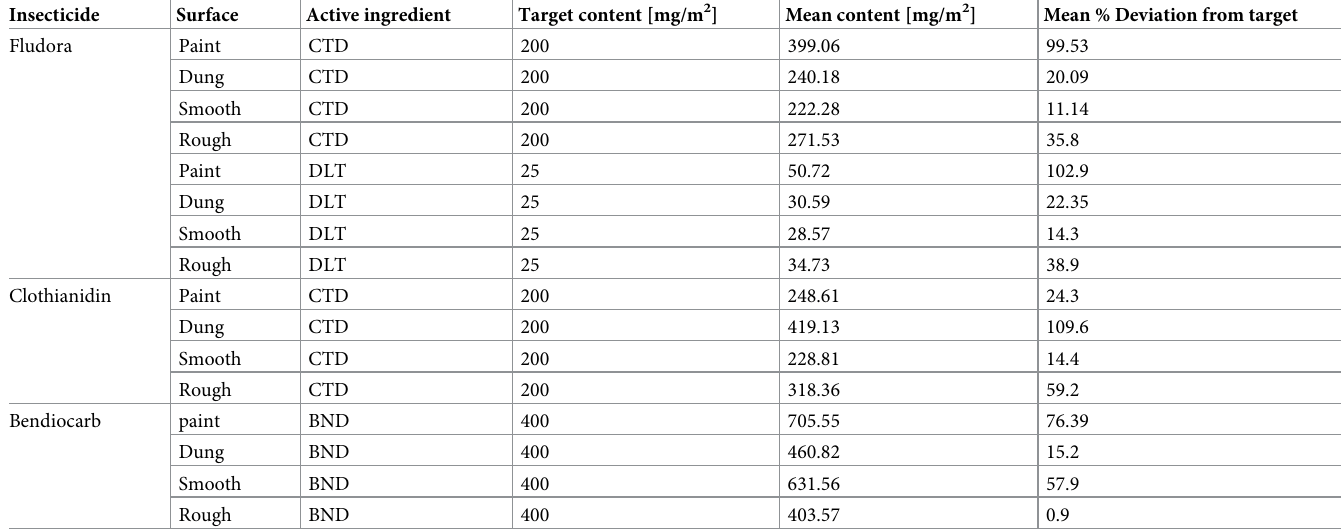
Table 1. Chemical papers from insecticide sprayed wall surfaces of experimental huts, Ethiopia.